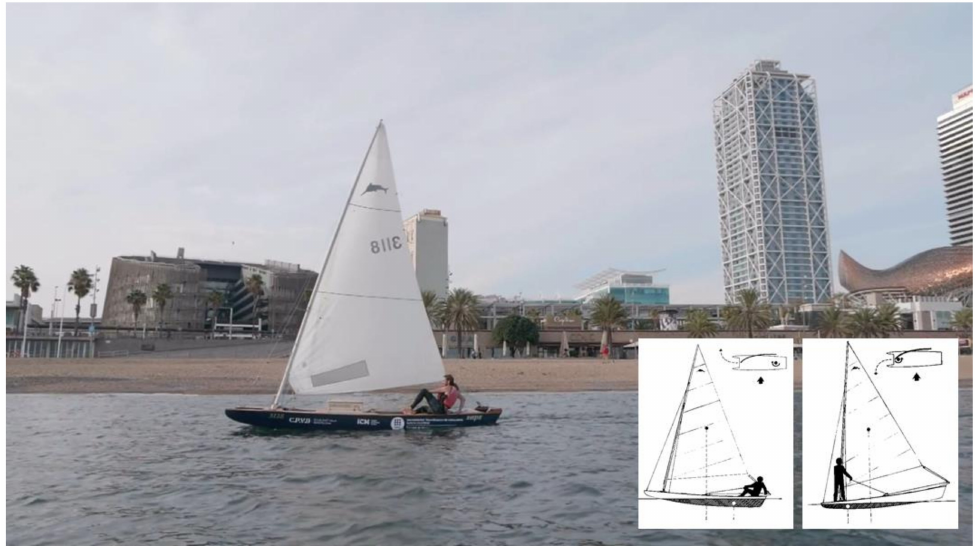
Figure 1. Picture of an SPV while departing from the CPVB premises, near downtown Barcelona, with the ICM facilities at the back. The insets illustrate the steering control of the PV, reprinted/adapted with permission of Ref. [17]. 1974, Editorial Hispano